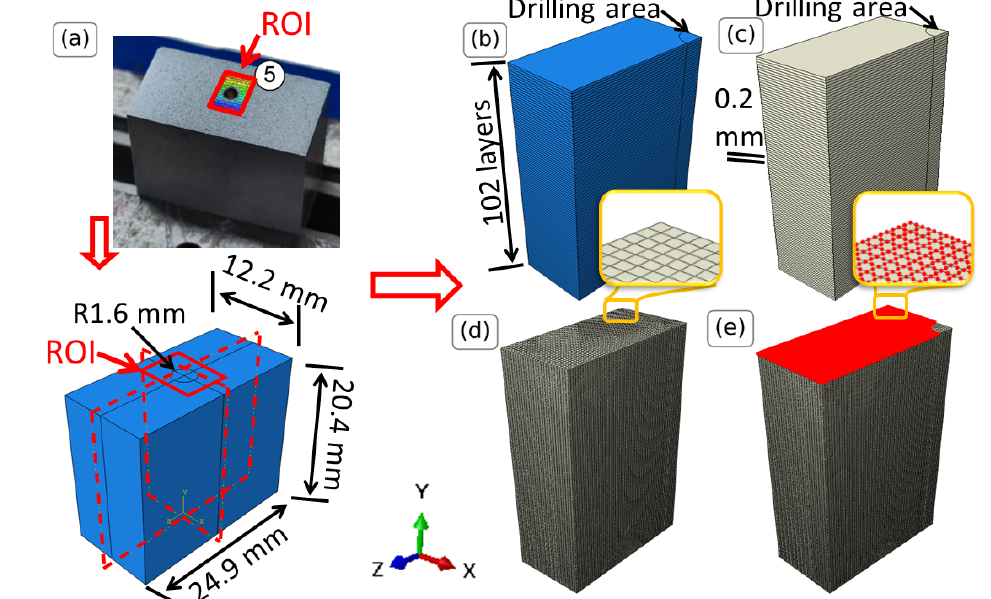
Figure 5. FE model of the IHD test. ( a ) Creating and partitioning of the full model due to symmetry, ( b ) thickness of printed layers, ( c ) steel material used in the modeling (in white), ( d ) meshed structure, ( e ) nodes (in red) from which the displacements are